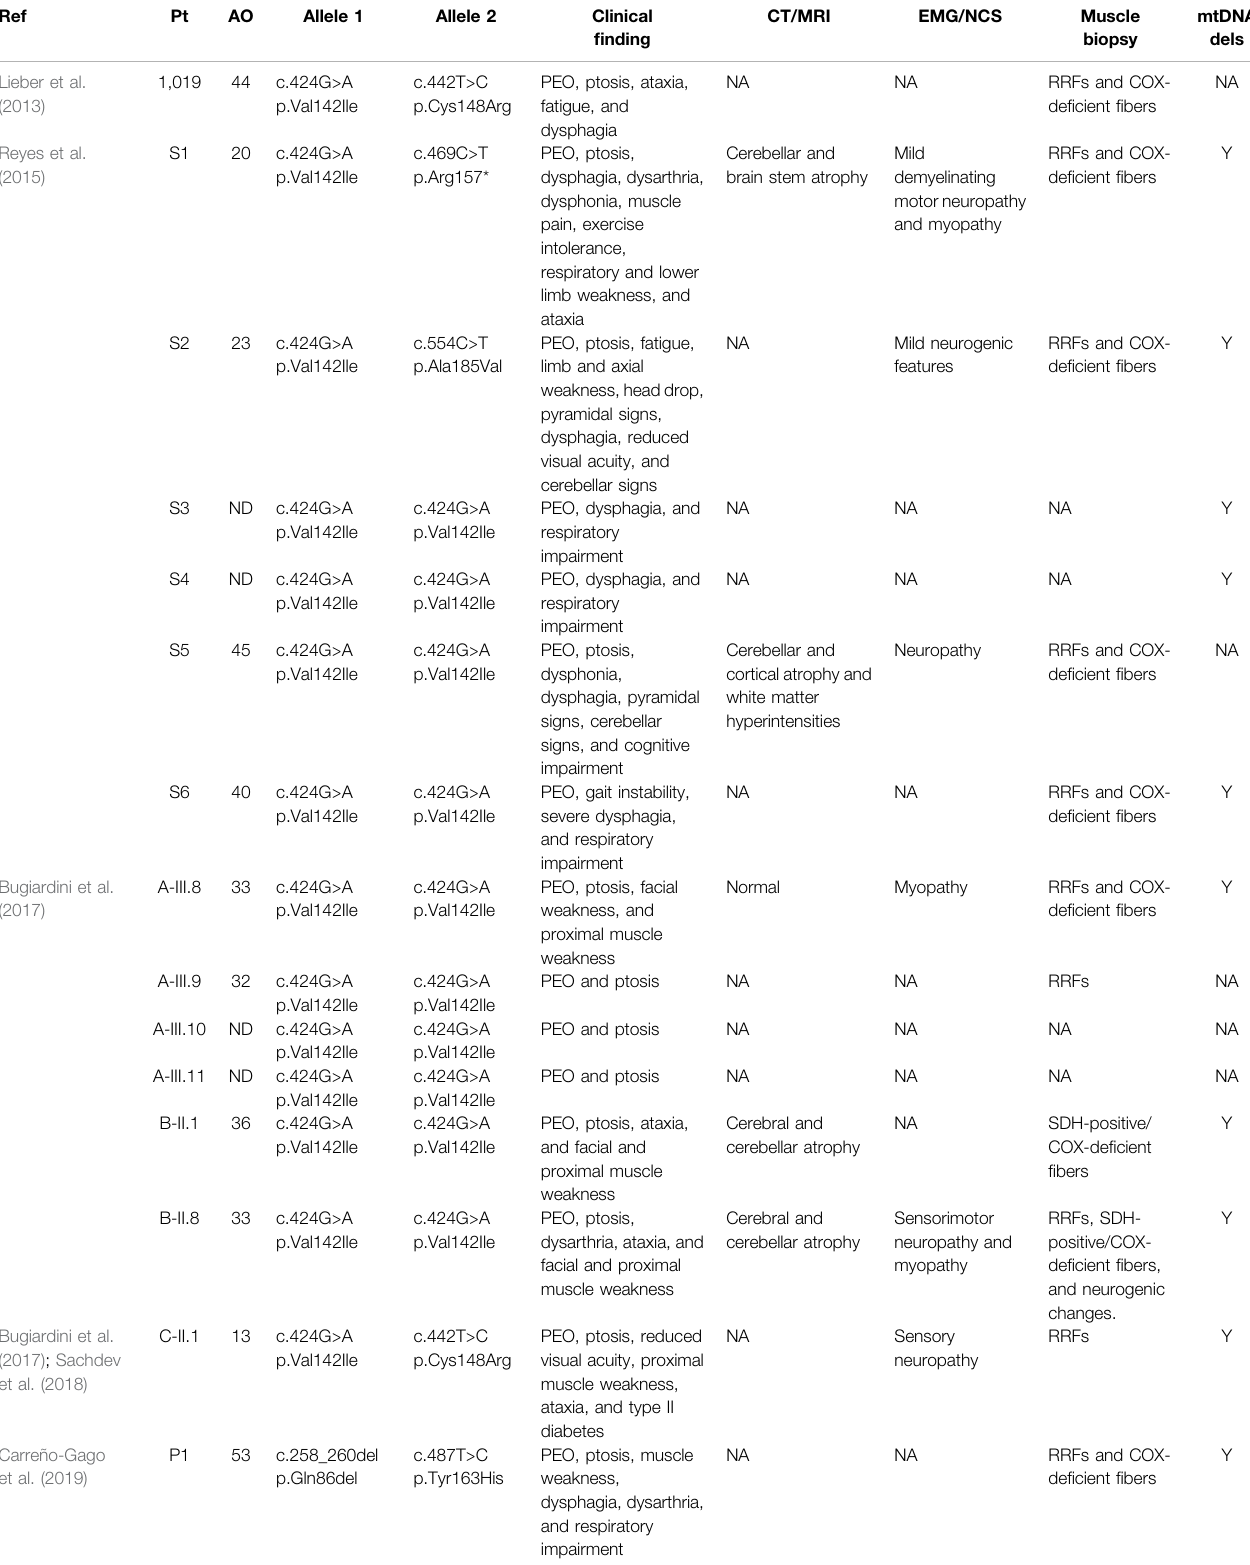
TABLE 1 | List of RNASEH1 -mutated patients described so far. Ref